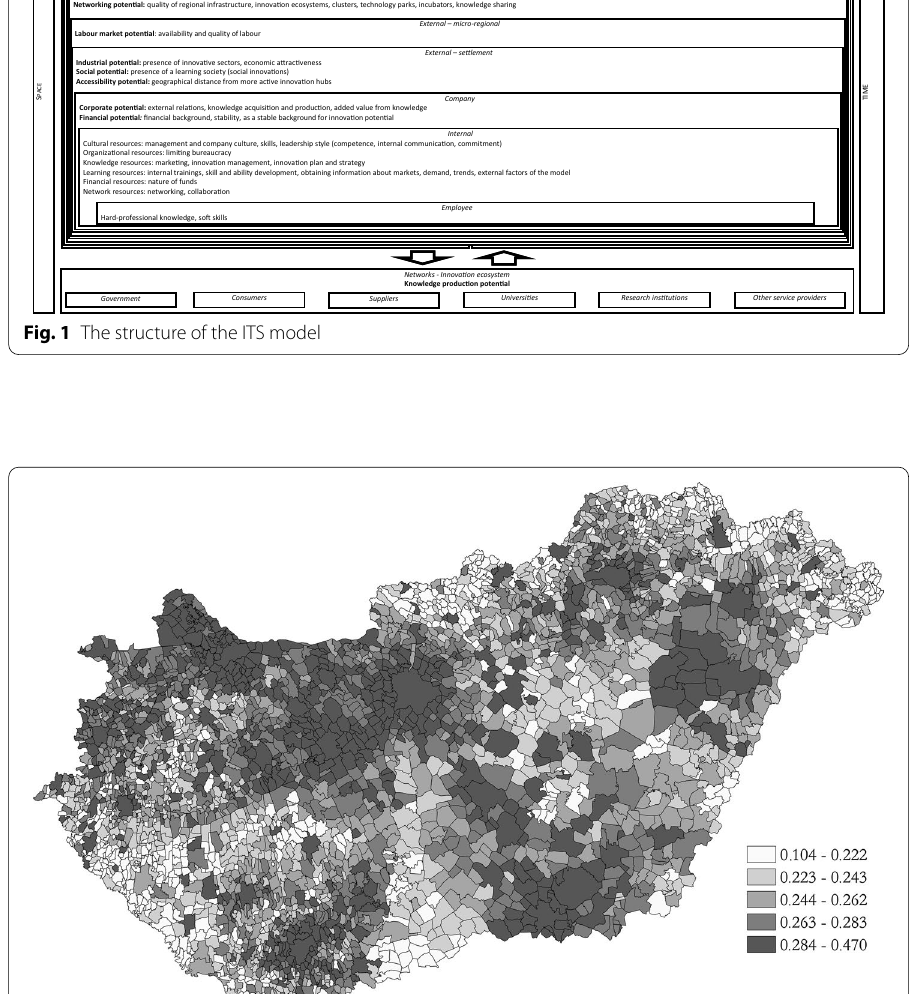
Fig. 2 The cartogram of innovation potential